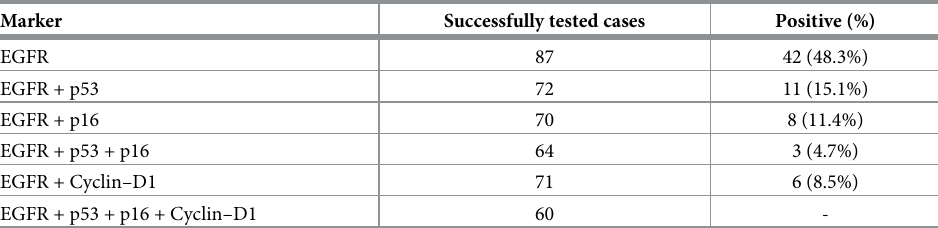
Table 4. Combined positivity of EGFR and other markers.